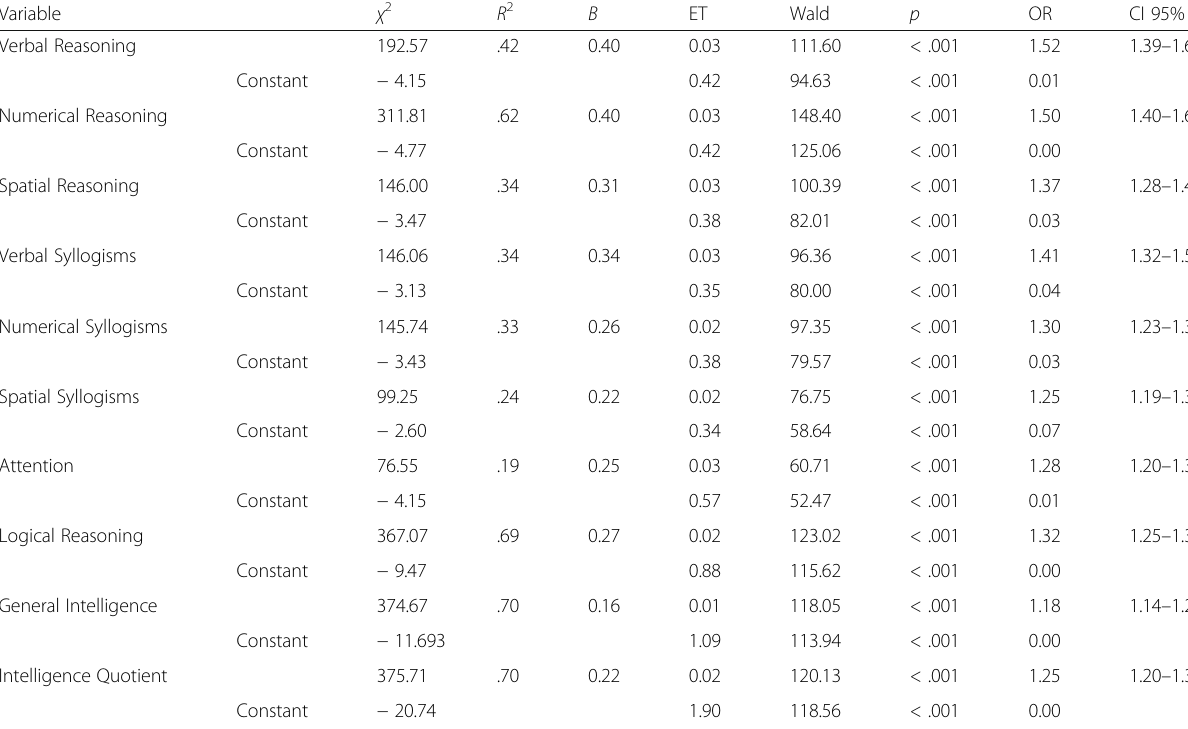
Table 5 Logistic regression for the predictive probability of each one of the cognitive aptitudes of the BADYG-E2 of not dropping the instrumental subject of Mathematics